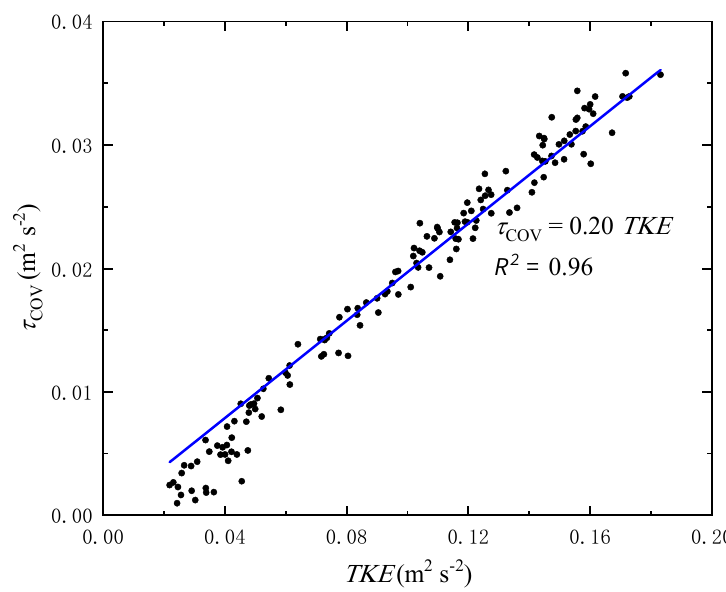
Figure 5. Relationship between the bottom shear stress ( τ COV ) estimated from the direct covariance (COV) method and the turbulent kinetic energy ( TKE ).